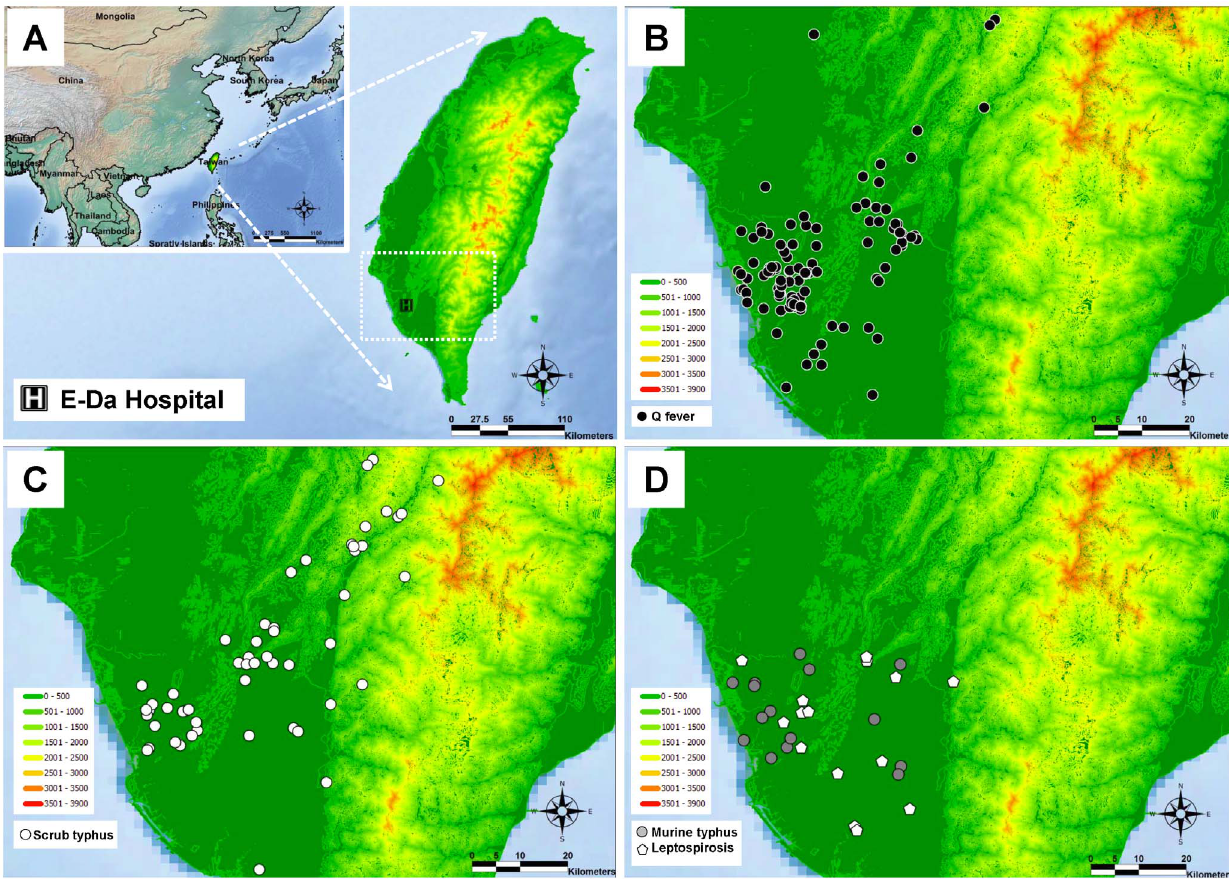
Figure 1. The case distribution of confirmed Q fever, scrub typhus, murine typhus, and leptospirosis. A: The geographic location of Taiwan and E-Da hospital. B: The case distribution of acute Q fever (black circles). C: The case distribution of scrub typhus (white circles). D: The case distribution of murine typhus (gray circles) and leptospirosis (white pentagons).